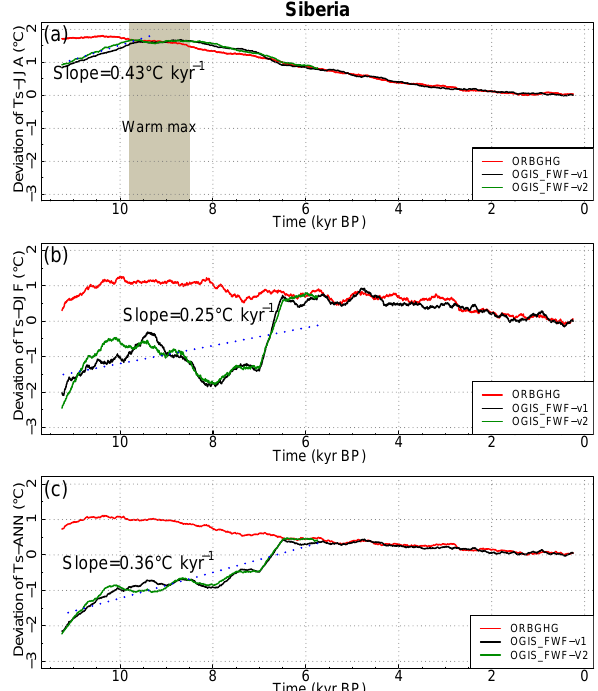
Figure 8. Same as Fig. 4 but for Siberia (62–145 ◦ E, 58–74 ◦ N) and the warming rate slope is indicated for a shorter period (11.5–